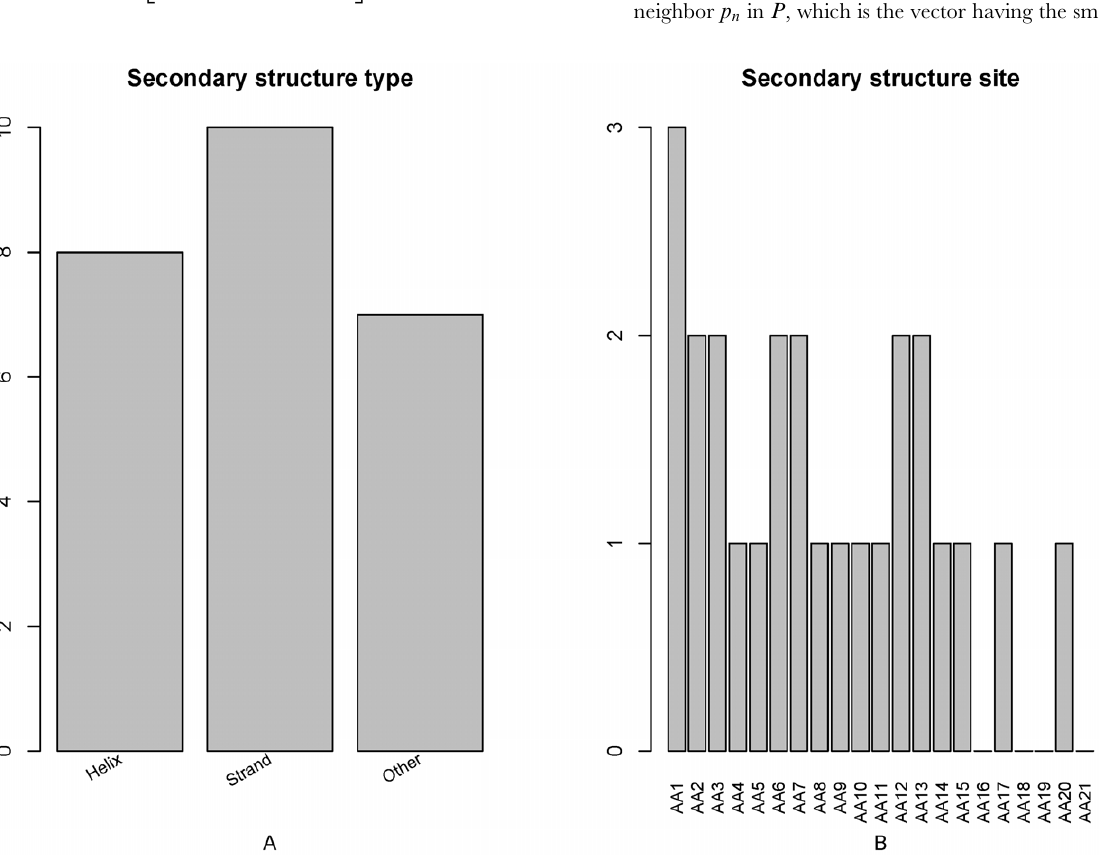
Figure 5. Feature and site specific distribution of the secondary structure features in the optimal feature set. (A) Feature distribution of the secondary structure features in the optimal feature set. All the three types of secondary structure features (helix, strand and other) can influence the PCA modification site determination. (B) Site-specific distribution of the secondary structure features in the optimal feature set. The secondary structure of site 1 may influence more to PCA modification site determination than other sites. The secondary structure features at site 2, 3, 6, 7, 12 and 13 may also influence more on PCA site determination.